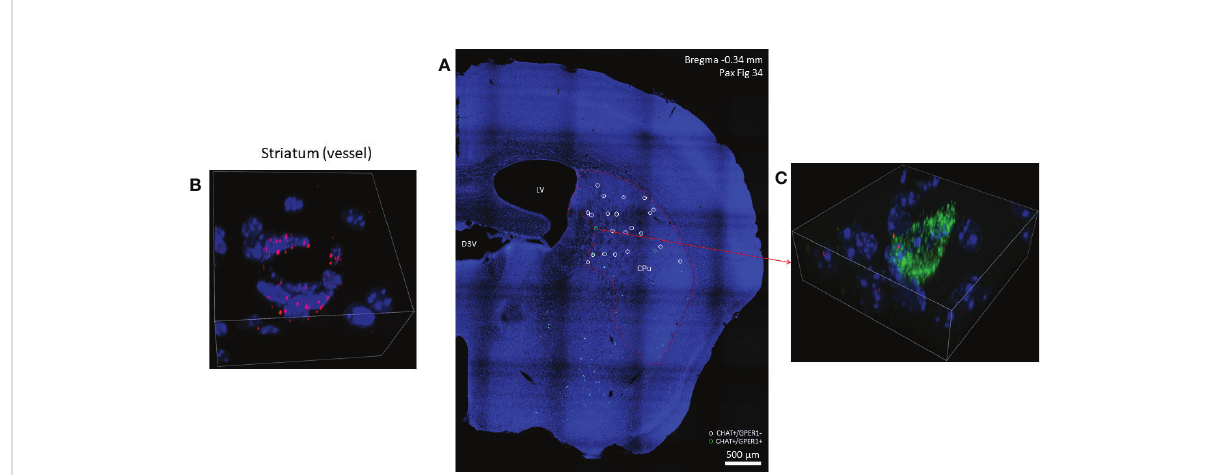
FIGURE 5 GPER1 (GPR30) mRNA expression in striatal cholinergic neurons. In one half of a coronal section cholinergic neurons marked with green, fl uorescent probes used against CHAT mRNA are depicted in Panel (A) (10x). GPER1-positive striatal cholinergic interneurons are marked with green open circles while white open circles show cholinergic neurons with no GPER1 mRNA expression in the dorsal striatum. In Panel (B) , endothelial cells of a small vessel abundantly expressing GPER1 mRNA are depicted (60x). One GPER1-positive striatal cholinergic interneuron is shown in Panel (C) (blue: nuclei, green: CHAT mRNA, red: ER a mRNA, 60x). CPu, caudate-putamen; LV, lateral ventricle; D3V, third